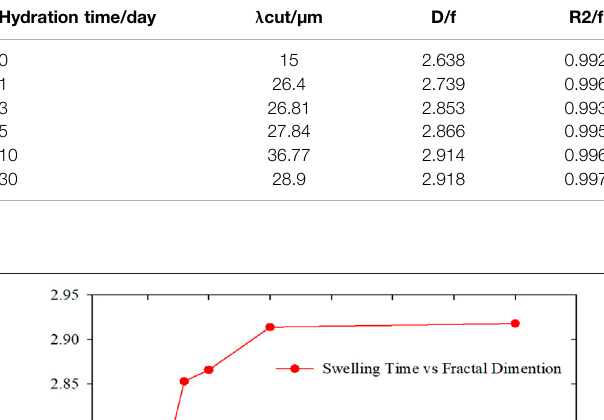
Frontiers in Chemistry |